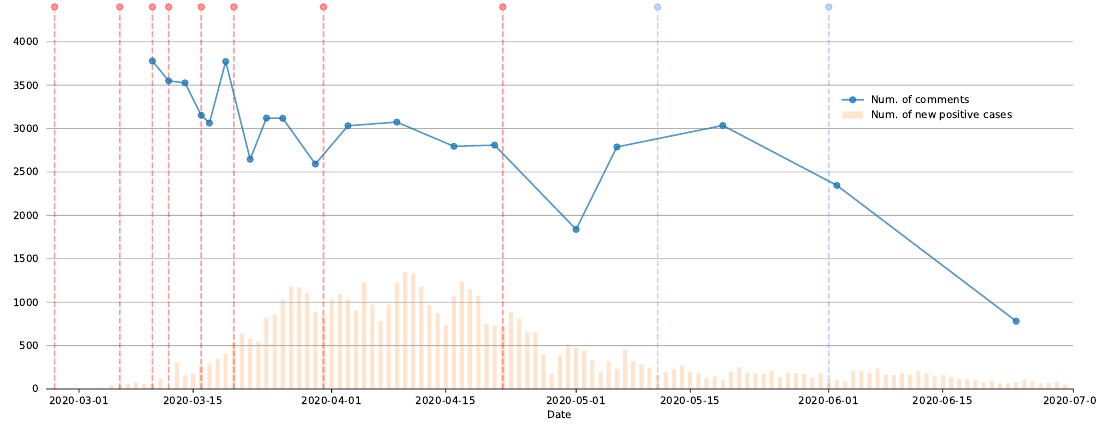
Figure 7. Number of comments per megathread in /r/thenetherlands compared to the number of new daily cases in The Netherlands. Vertical lines represent adopted critical events and